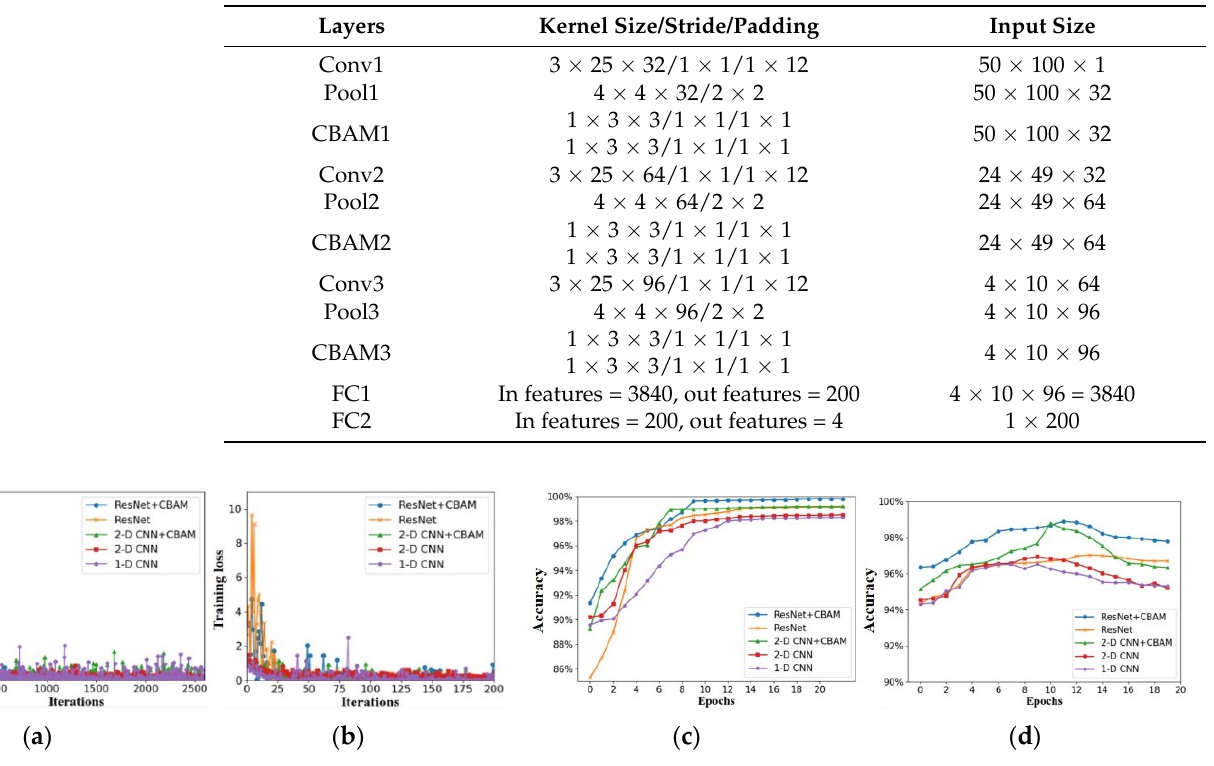
Figure 8. Training loss comparison of the five models: ( a ) the whole curve, ( b ) the enlarged part, and comparison of the five models in the processes of ( c ) training and ( d ) validation.